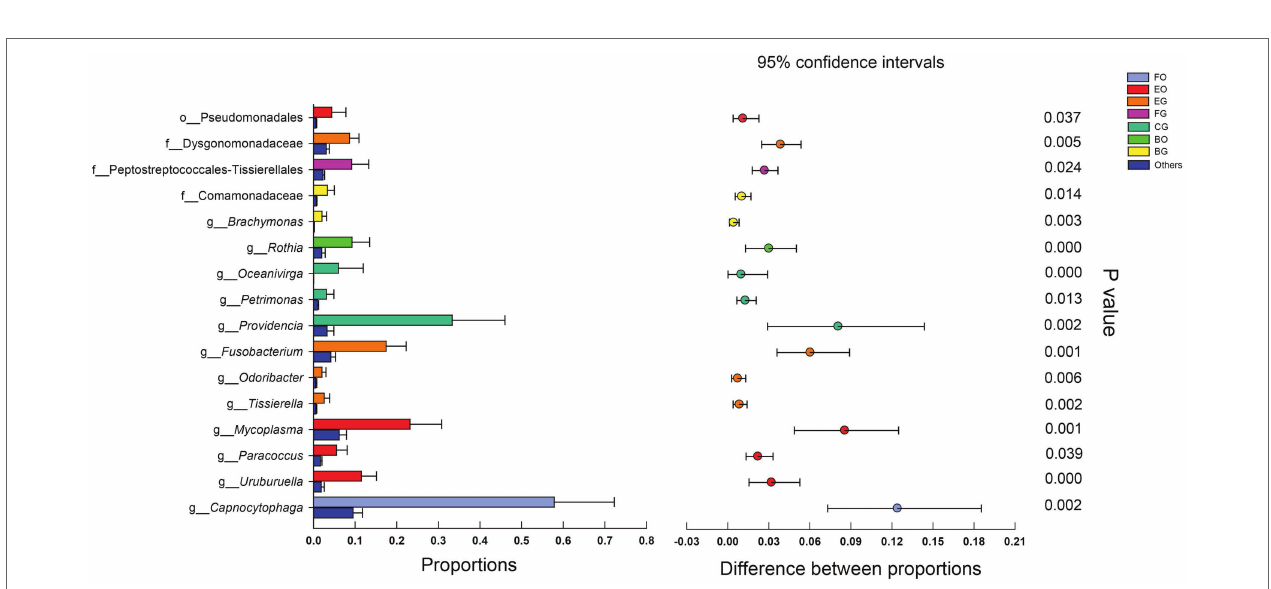
FIGURE 4 | Differences in oral and gut bacterial taxa among the eight groups are determined by linear discriminant analysis effect size (LEfSe; A ). Linear discriminatory analysis (LDA) scores reflect the differences in relative abundance among the eight groups (B) . See Figure 1 for the definition of every group. The letters “o,” “f,” and “g” indicate order, family, and genus, respectively.